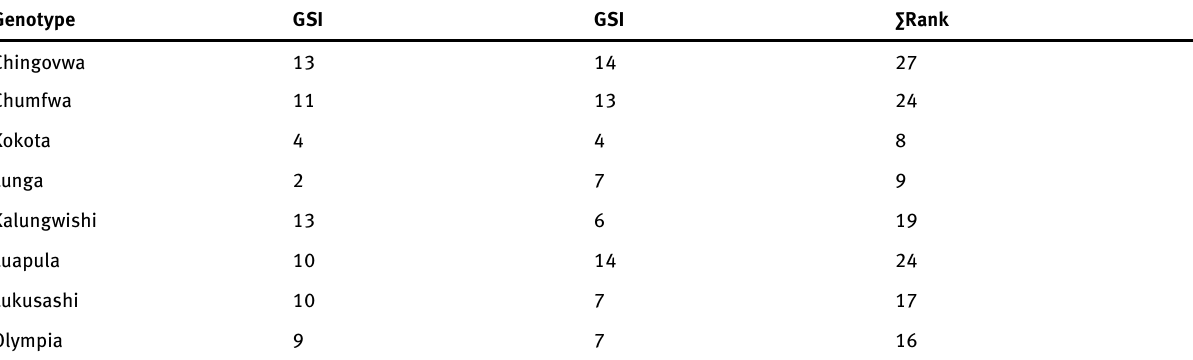
Table 6: Rank sum of genotype stability indices for root yield and weevil damage